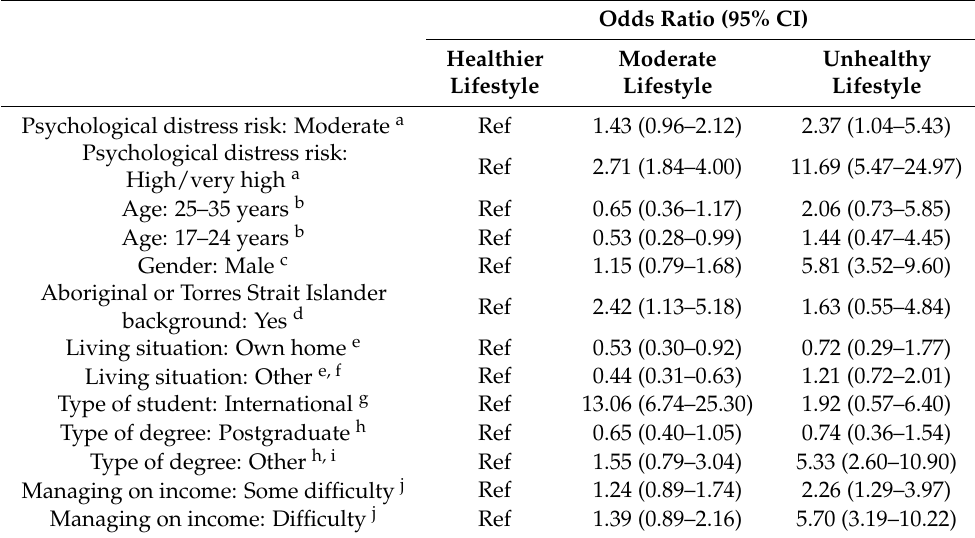
Table 3. Odds of class membership by psychological distress risk and demographic characteristics among a sample of Australian university students ( n =